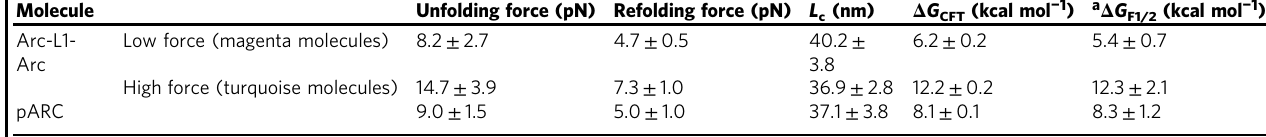
Table 1 Thermodynamic and mechanical properties of Arc-L1-Arc and pARC Molecule